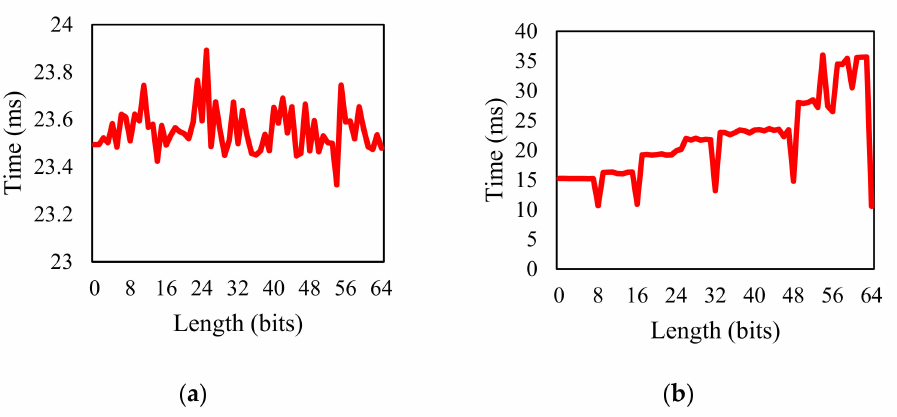
Figure 12. Time required to search or update the global state 1,000,000 times with an offset of 8 bits and different lengths. ( a ) Search state. ( b ) Insert